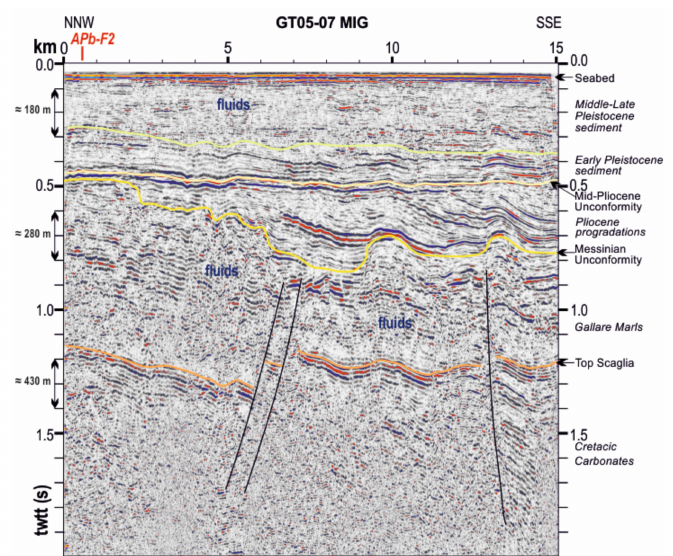
Figure 4. High penetration multichannel time migrated seismic profile GT05-07, offshore the Taglia- mento river delta. The seismic profile shows the sedimentary sequence composed of Meso-Cenozoic carbonates of the Belluno Basin, buried under the Eocene-Miocene Gallare Marls. These at the top are depicted by the Messinian Unconformity, covered by Pliocene progradations, which are in turn cut by the Mid-Pliocene Unconformity. Early Pleistocene marine progradation sediments seal the entire sequence, which in turn are covered by the alternation of continental and marine Middle-Late Pleistocene sediment. Along the vertical scale of the profile, the approximate correspondent thick- ness of 0.2 s twt (two way time) in meters is reported, calculated by using mean P-wave velocity values (obtained by tomographic analysis; [72–75]), of 1750 m/s, 2800 m/s and 4300 m/s for the Plio-Quaternary sediments, Eocene-Miocene deposits and Meso-Cenozoic carbonates, respectively. The seismic image shows presence of fluids within the sedimentary sequence.